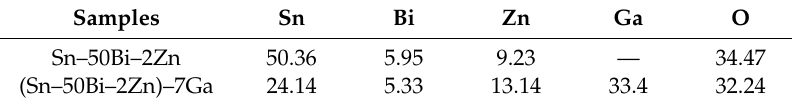
Table 4. The compositions of the oxide films measured by XPS (Atomic %).